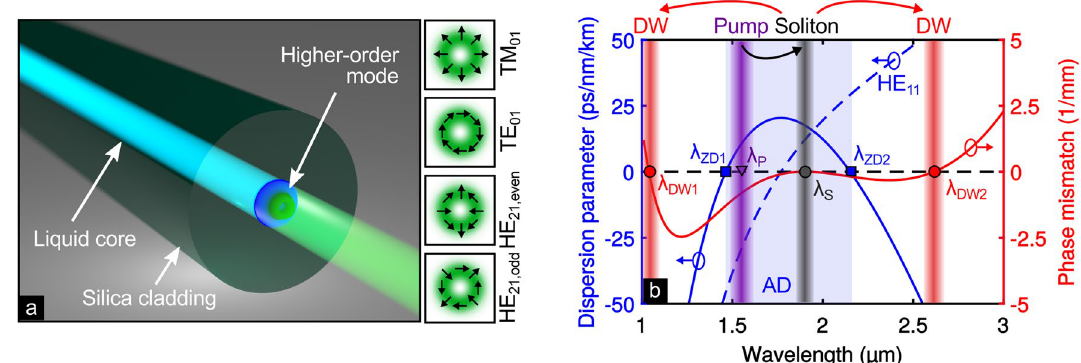
Figure 1. Double zero-dispersion wavelengths for HOMs in LCFs. ( a ) Sketch of higher-order mode propagation in a liquid core fiber, with polarization and intensity distributions of the investigated TM 01 , TE 01 , and HE 21 modes shown on the right (black arrows indicate the direction of the electric field at a fixed point in time). ( b ) Schematic of dual dispersive wave (DW) generation by soliton fission for the TM 01 mode in a CS 2 -core silica fiber (Ø core = 4 µm). The group velocity dispersion profile (blue line) has two ZDWs (λ ZD1 and λ ZD2 ) and an anomalous dispersive regime (AD, blue shaded) at the pump wavelength λ P = 1.56 µm (purple bar), which allows to generate a soliton (gray bar) with an exemplary wavelength of λ S = 1.9 µm. Enclosed by two ZDWs, the soliton transfers energy to two DWs (red bars), whose wavelengths (λ DW1 and λ DW2 ) can be determined by the phase-matching condition (red line). For the same fiber geometry, the fundamental mode (blue dashed line) is normal dispersive at λ P